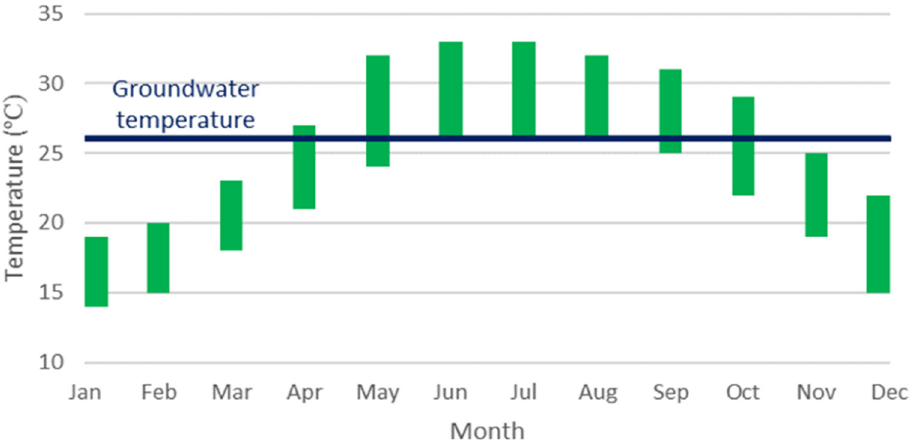
Figure 3. Comparison of atmospheric and subsurface temperatures in Hanoi (modified based on the report by Yasukawa et al. [40]).